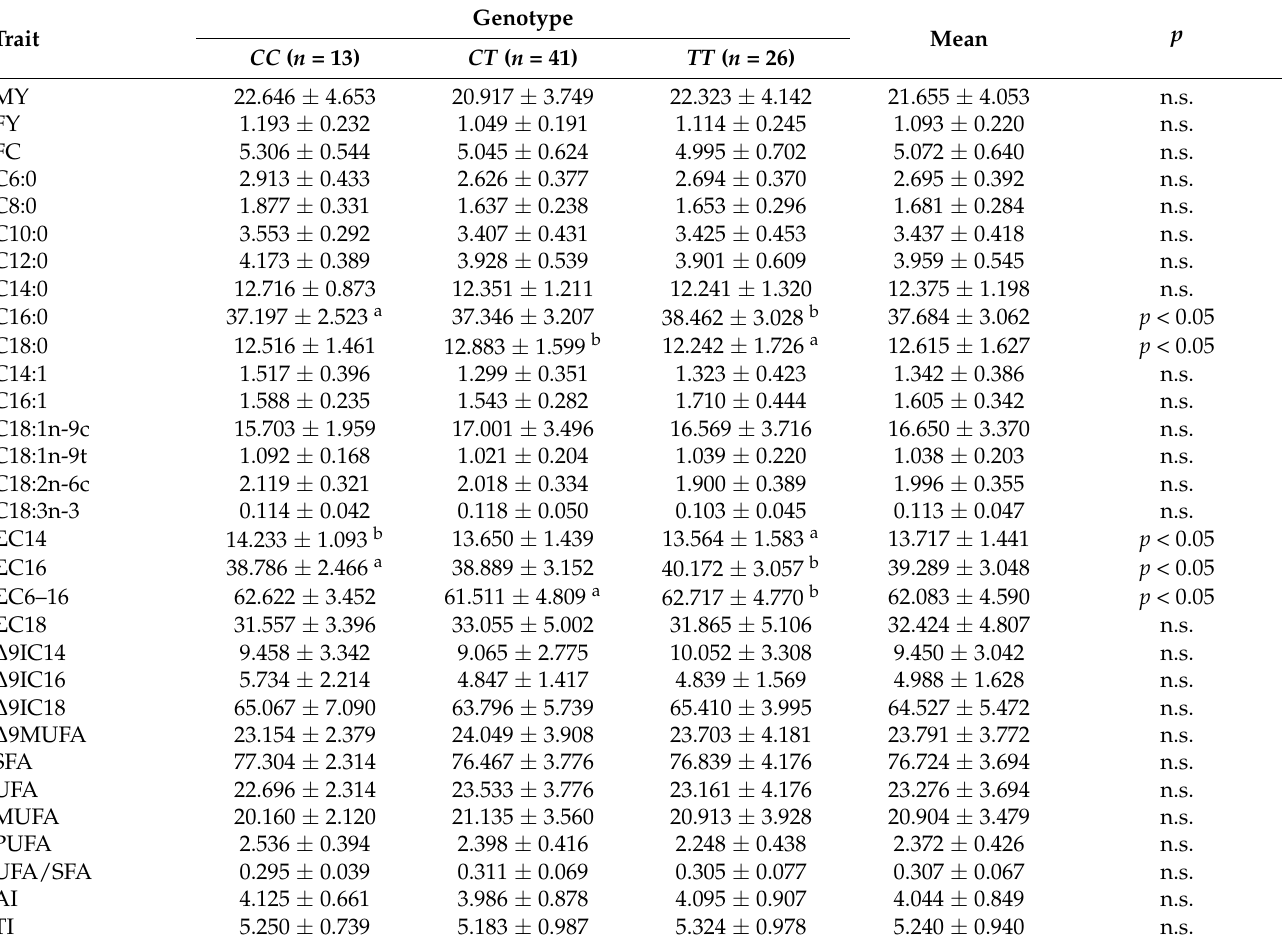
Table 3. Association of THRSP genotypes with analyzed traits of milk in Jersey